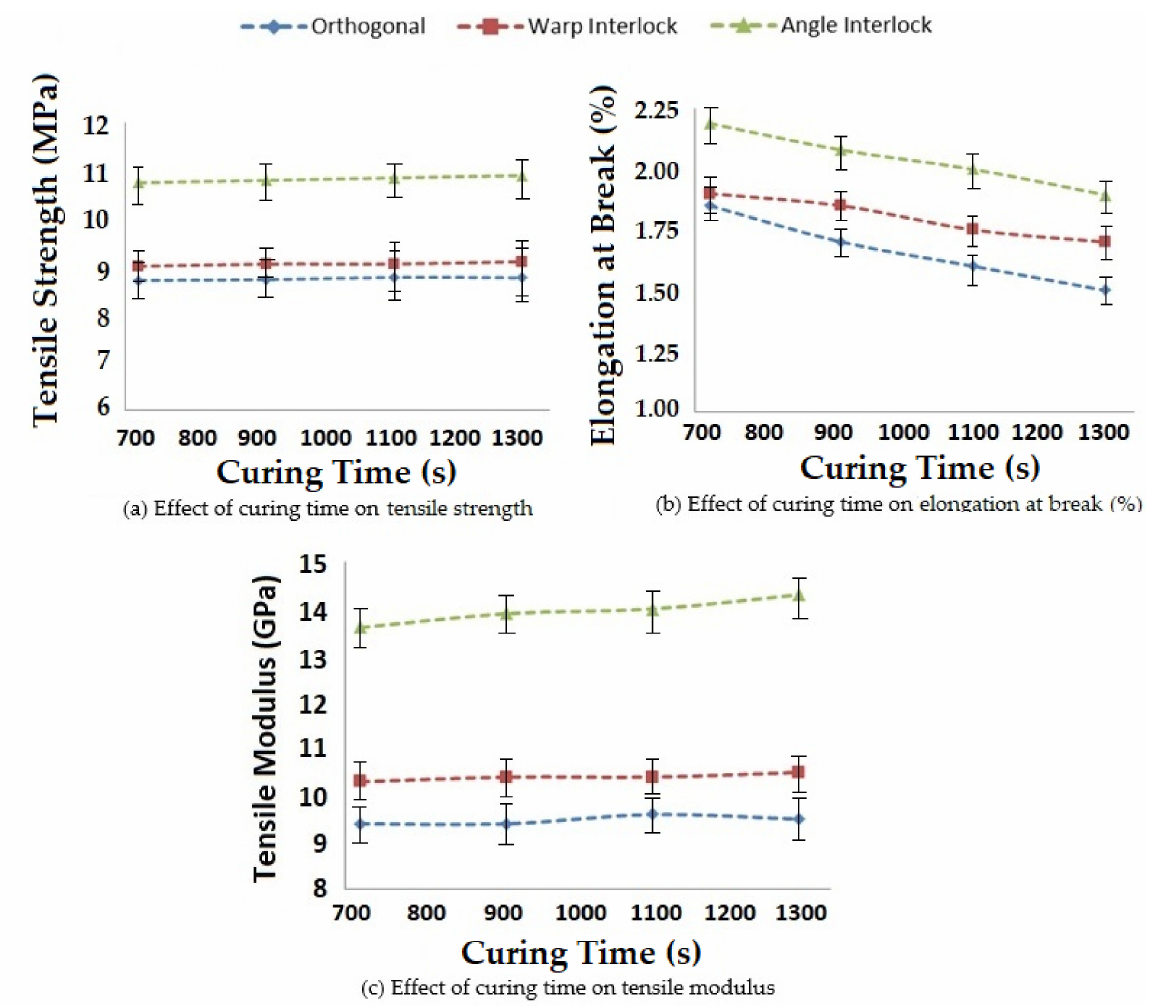
Figure 8. Effect of curing time on the tensile properties of 3D woven